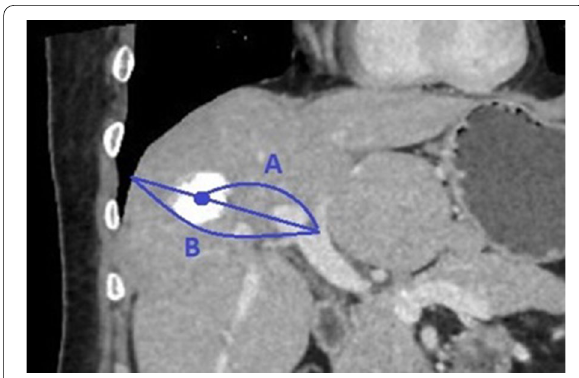
Fig. 1 The coefficient of the HCC distance from the hilum of the = liver at the portal vein bifurcation to the center of the HCC ( A ) divided by the diameter of the whole liver on the same line ( B )